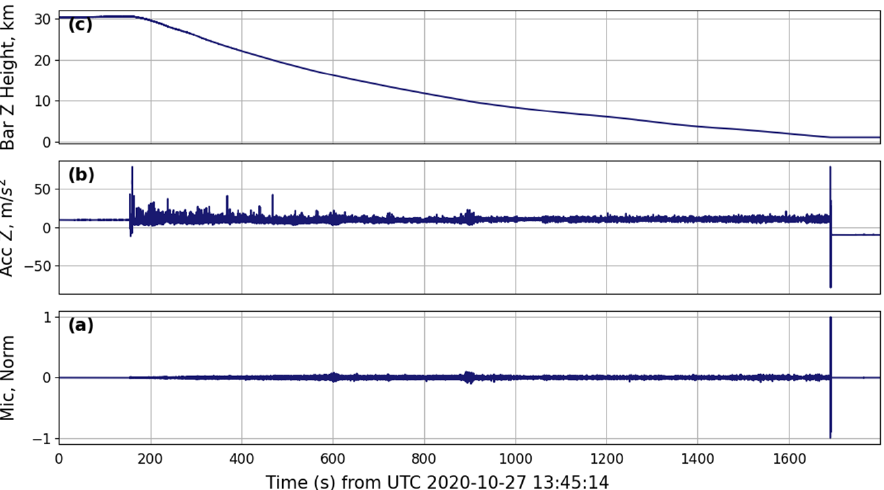
Figure 12. Sensor payloads for ( a ) audio, ( b ) Z-component acceleration, and ( c ) height inferred from barometric pressure.